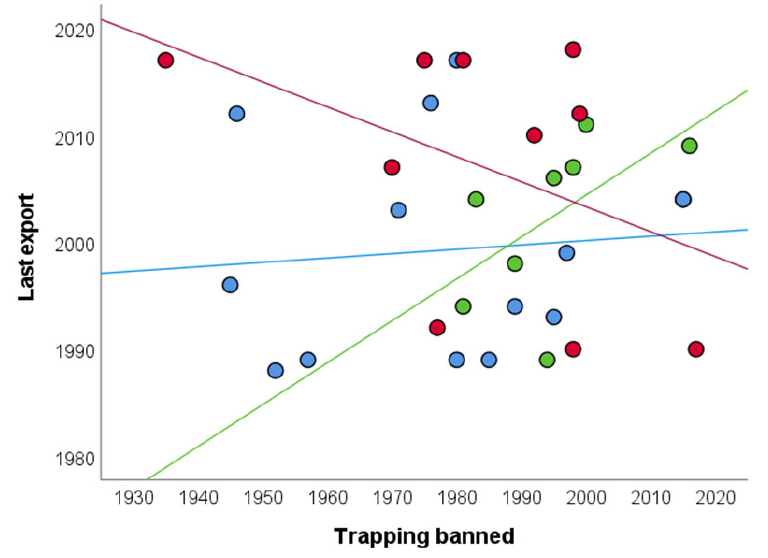
Figure 4. Relationships between the years in which each Neotropical country prohibited trapping wild parrots for the domestic demand of pets ( X ‐ axis) and the years they performed the last legal exports of wild ‐ caught parrots for the international pet markets ( Y ‐ axis). Countries are grouped by subregion as Caribbean (blue), Central American (green) and South American (red). Lines represent the correlation between both variables for countries within each region.